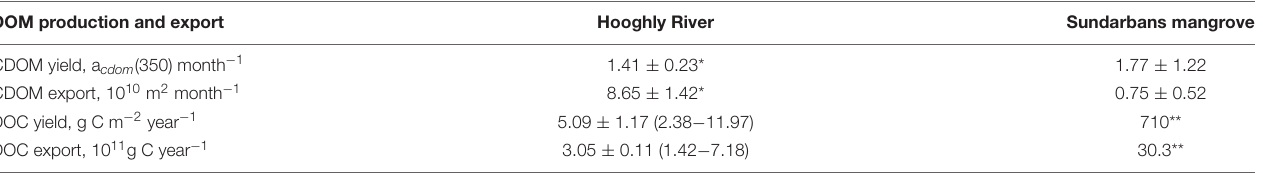
TABLE 4 | Annual yield and export of CDOM and DOC from the studied river and mangroves. DOM production and export Hooghly